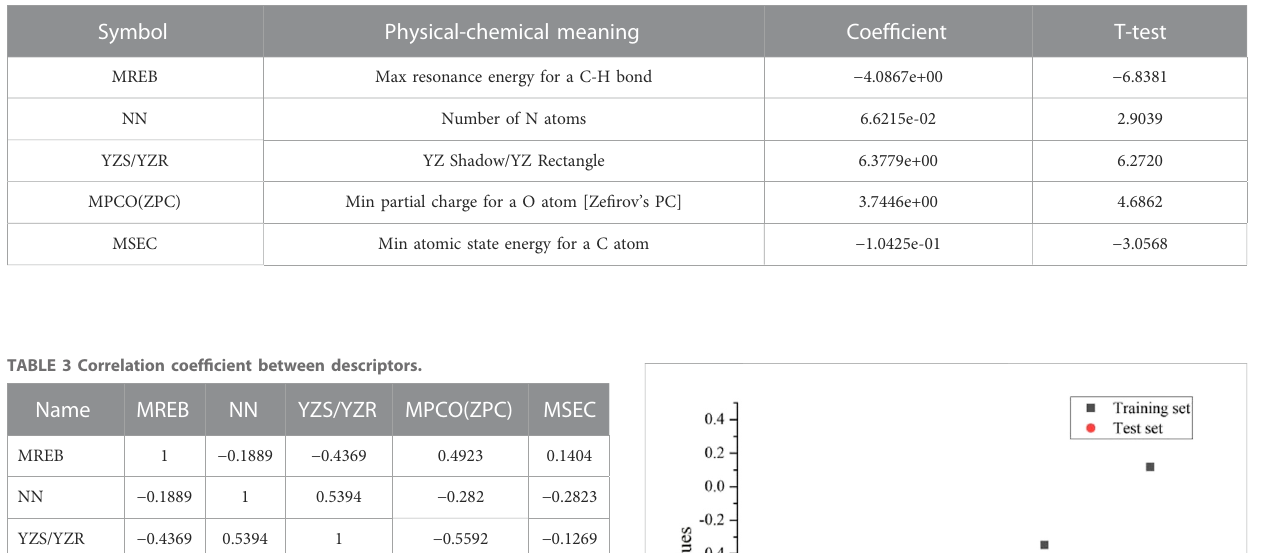
TABLE 2 Details of the fi ve selected descriptors.